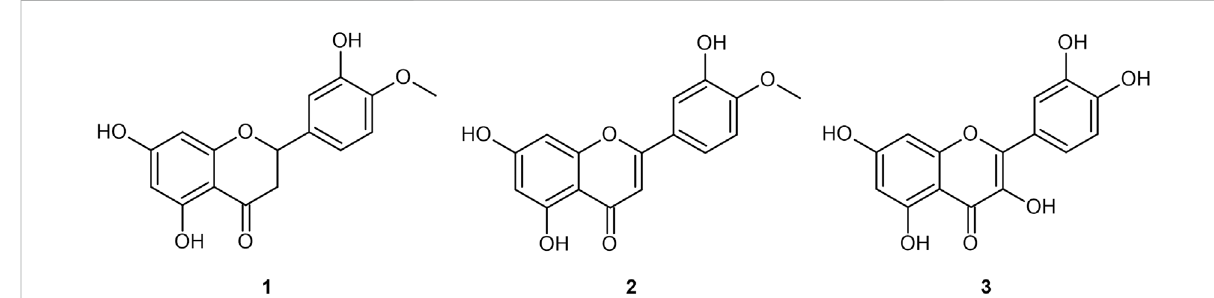
FIGURE 1 Four fl avonoid aglycones referenced in the present work: hesperetin (1) ; diosmetin (2) ; quercetin (3) .